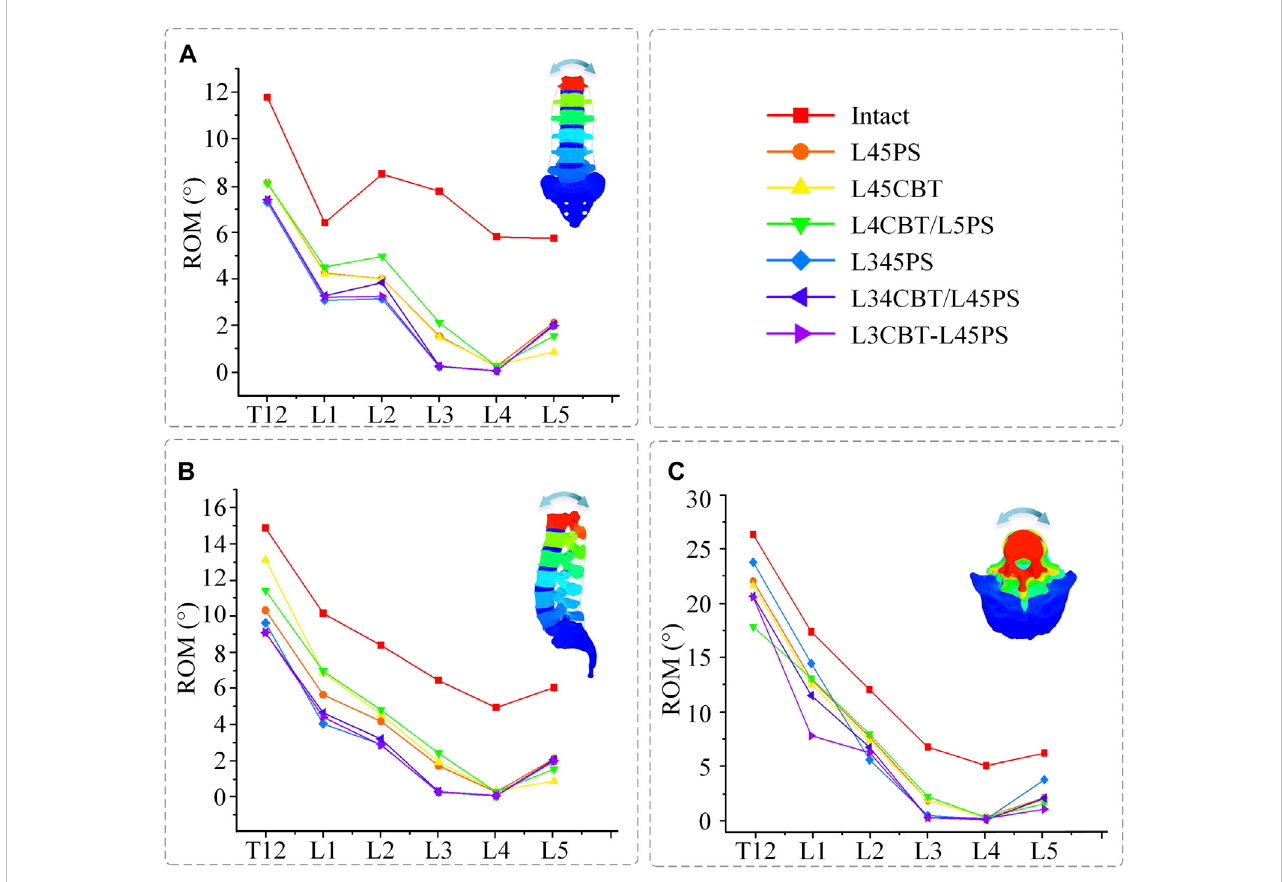
FIGURE 7 ROM for each segment between postoperative FEMs and the intact FEM. (A) Flexion – extension conditions. (B) Lateral bending conditions. (C) Axial rotation conditions.